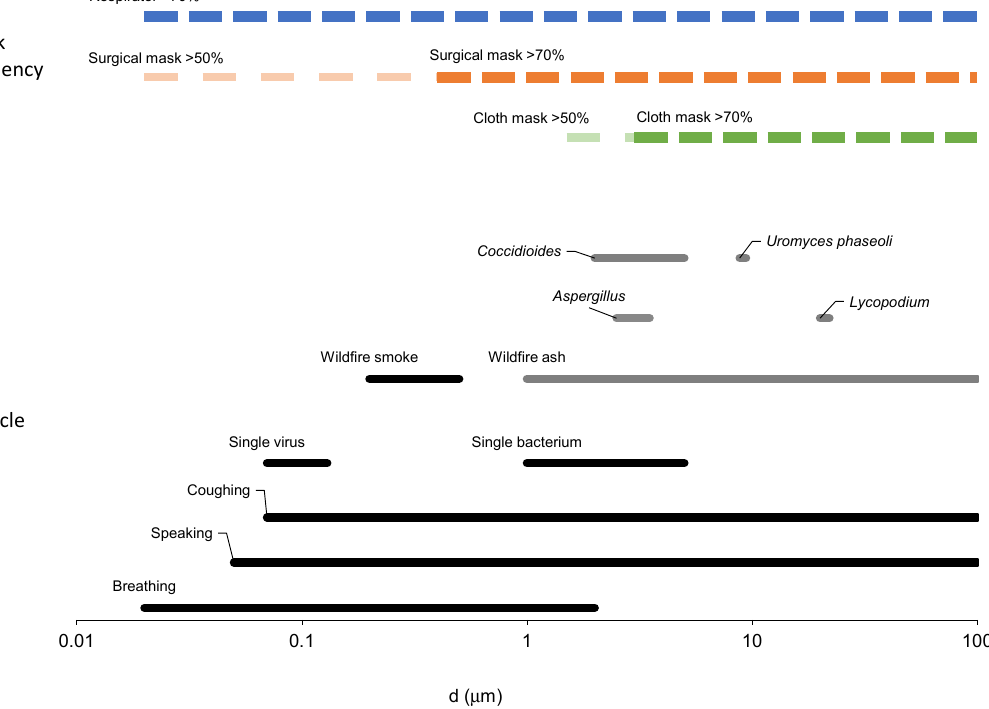
Figure 5. Size ranges for different particle types ( bottom of figure ) and the mask types predicted to have >50% and >70% efficiency at these sizes ( top of figure ). The coughing- and speaking-emitted particle size ranges are plotted independently of the bronchial mode B1 associated with breathing.